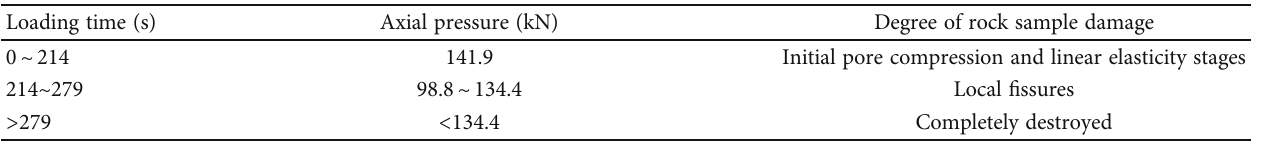
Figure 3: Pressure time-axial stress curve of MTS 816 (a) and strain evolution nephogram of axially pressurized distributed optical fi bers (b). Table 1: Loading process of the rock